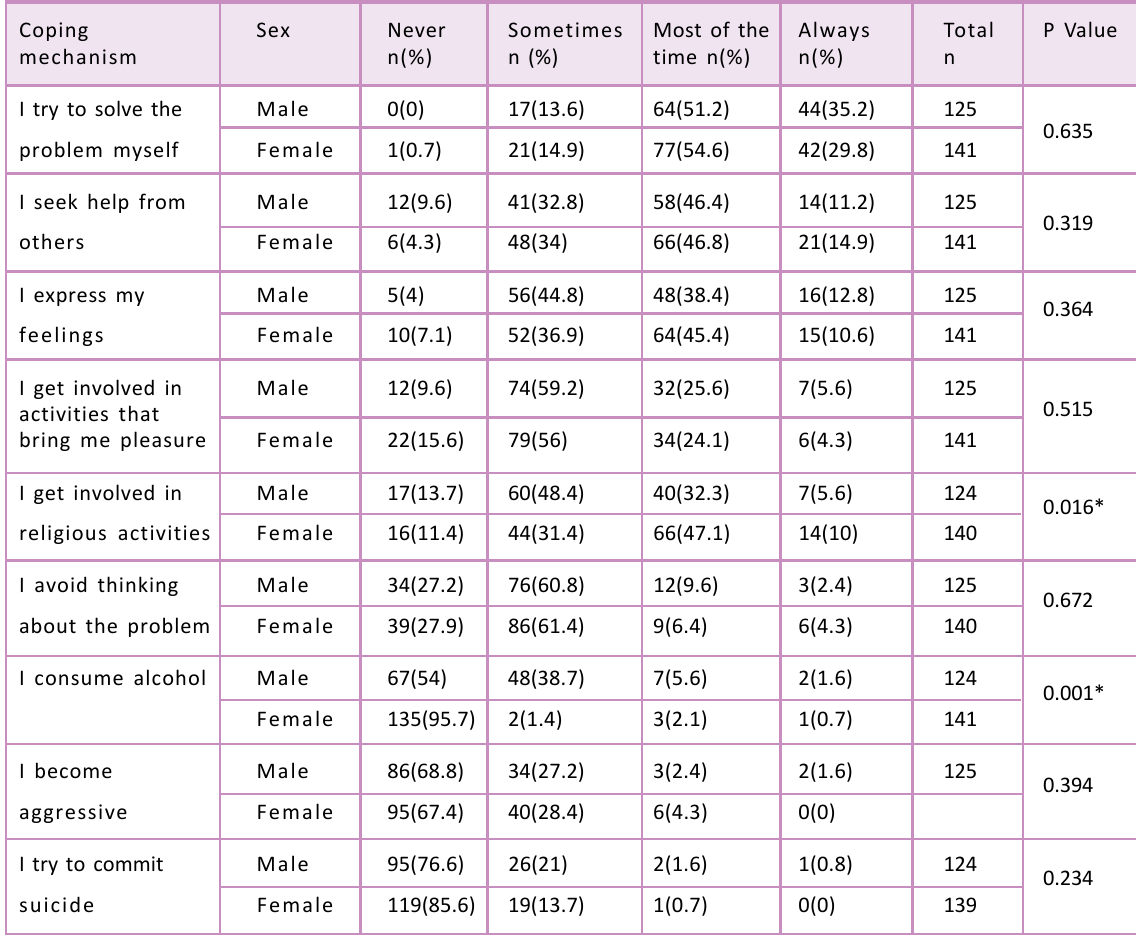
Table 1. Coping strategies used by persons with DSH